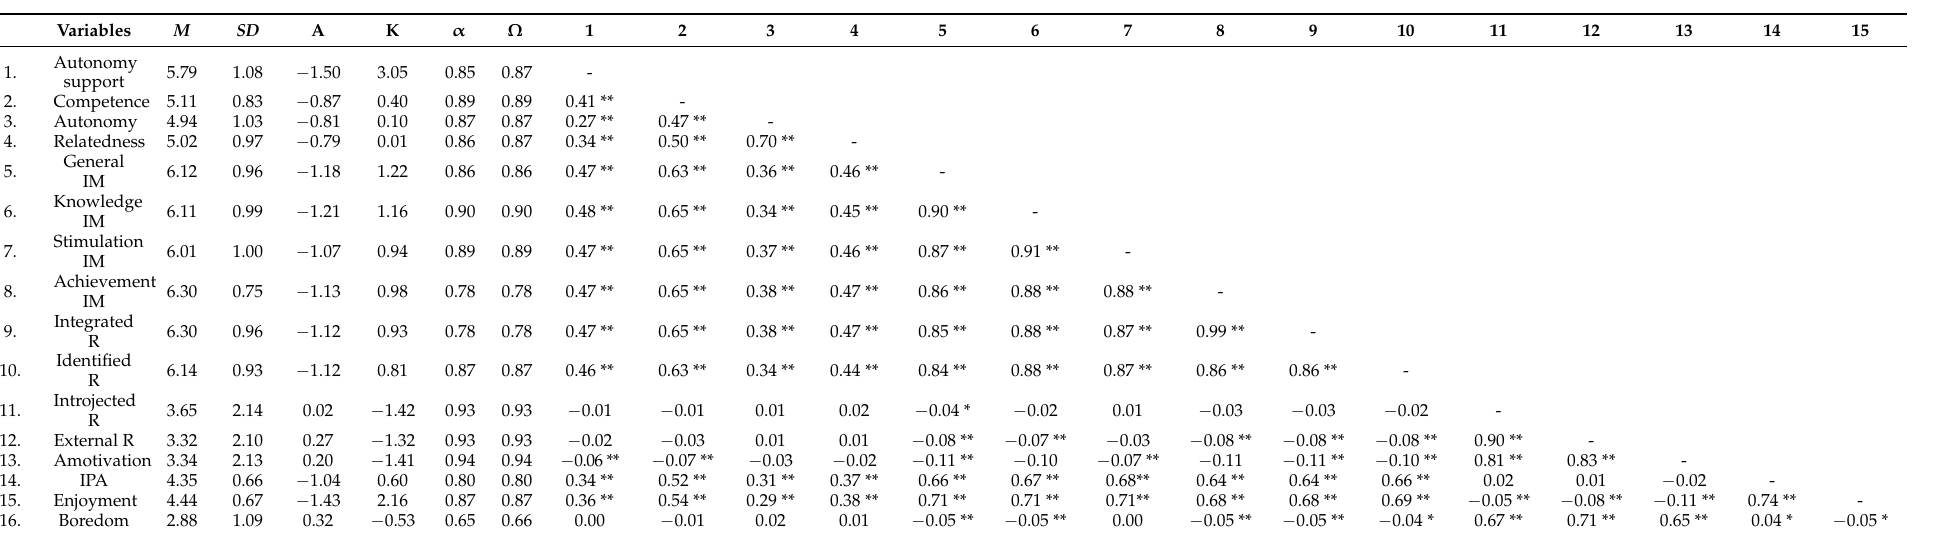
Table 1. Descriptive analysis, reliability and